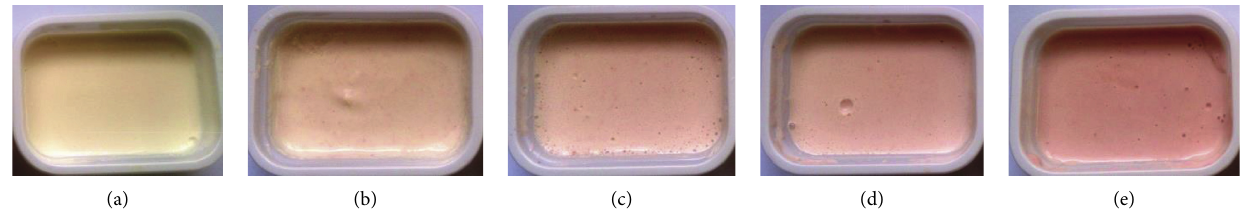
Figure 1: Pictures of surface Feta-type cheese containing different pomegranate juice concentrations. (a) 0%. (b) 5%. (c) 10%. (d) 15%. (e)